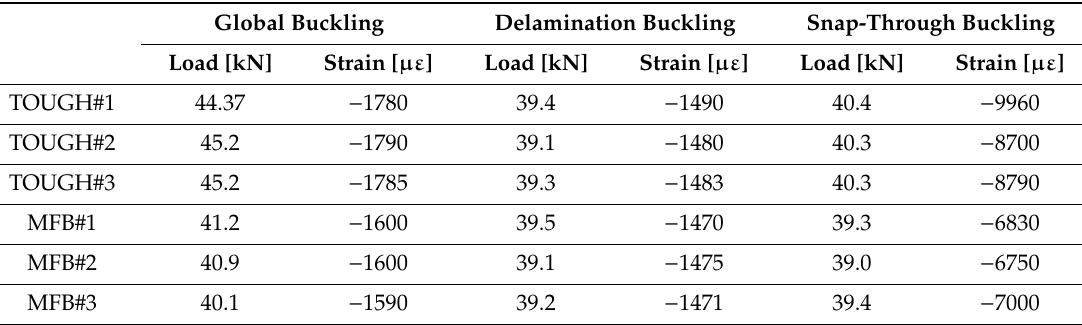
Table 2. Summary of experimental results.